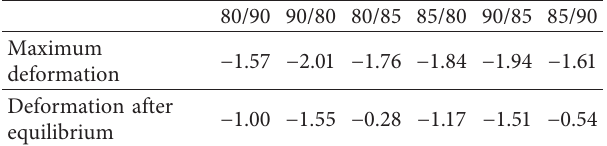
Table 4: Displacement of double-layer foamed aluminum under each combination.